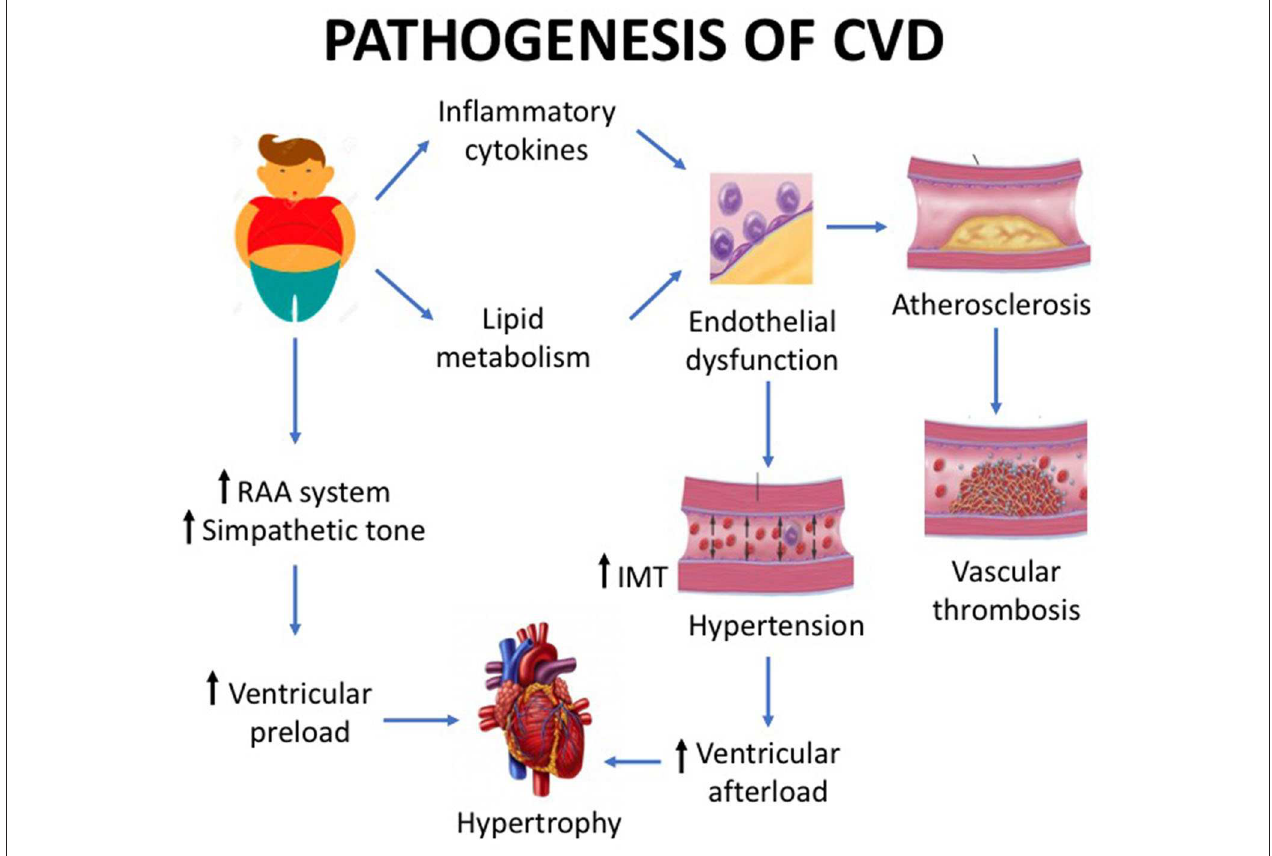
FIGURE 1 | Childhood obesity is associated with a number of cardiovascular structural and functional alterations. Basically, the pathogenesis of cardiovascular disease is caused by the increase in preload and by the vascular damage. The preload increase is mediated by the renin–angiotensin system, while the vascular damage by lipid metabolism impairment and pro-inflammatory cytokine pathway. The latter mechanisms cause endothelial dysfunction, which in turn leads to hypertension with ventricular afterload and endothelial damage with subsequent atherosclerosis. The effect of preload increase and vascular damage is myocardial